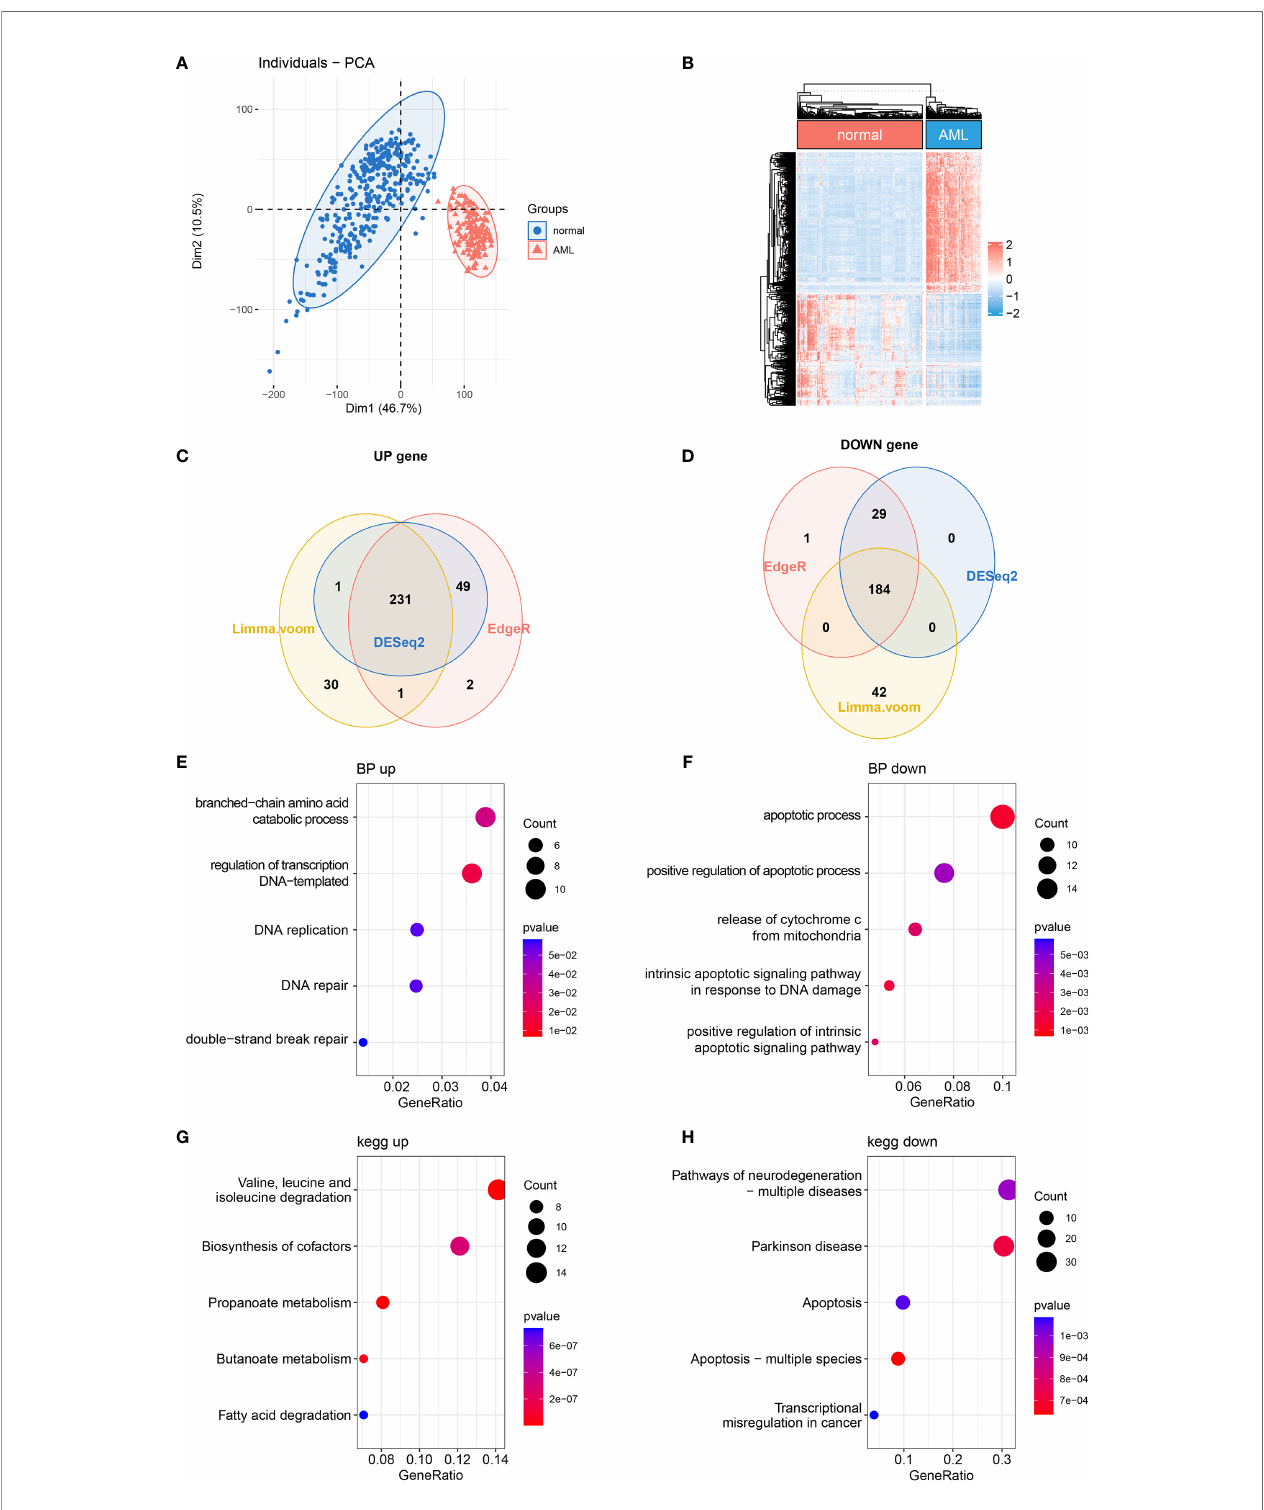
FIGURE 1 | Differentially expressed MRG analysis. (A) PCA and (B) DE MRG heatmap. (C, D) Venn plots of 3 different DE analyses. (E, F) Bubble plots of GO enrichment analysis of DE MRGs. BP, biological process. (G, H) Bubble plots of KEGG pathway enrichment analysis of DE MRGs. MRG, mitochondria-related gene; PCA, principal component analysis; DE MRGs, differentially expressed MRGs; GO, Gene Ontology; KEGG, Kyoto Encyclopedia of Genes and